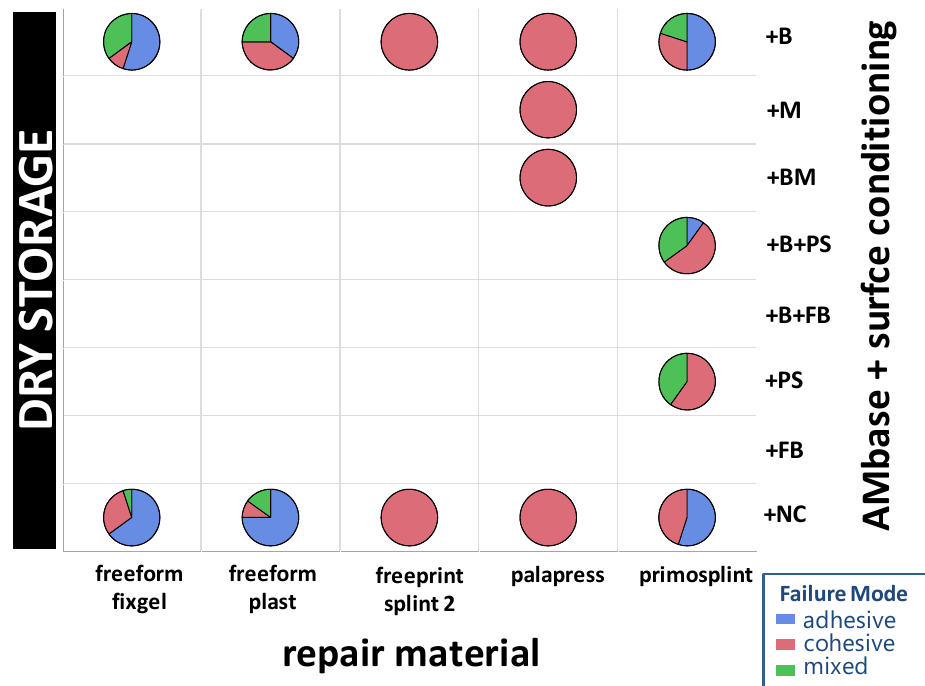
Figure 9. Distribution of failure modes of the repair materials ( x -axis) against AM base splint material depending on the conditioning (right y -axis) after dry storage. Rectangles without pie charts were not performed in dry storage condition due to protocol.